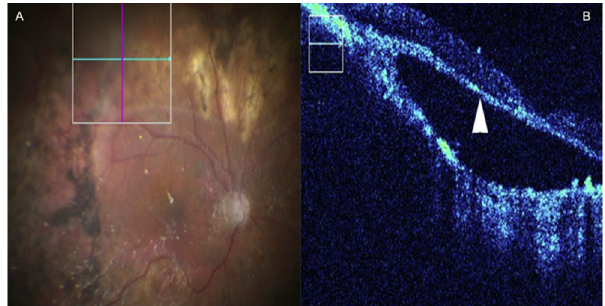
Figure 6. MI-OCT assisted Retinal detachment surgery. ( A ) En-face view. ( B ) MI-OCT shows a subretinal membrane consistent with proliferative vitreoretinopathy (arrowhead). Reproduced with the permission from reference [87].